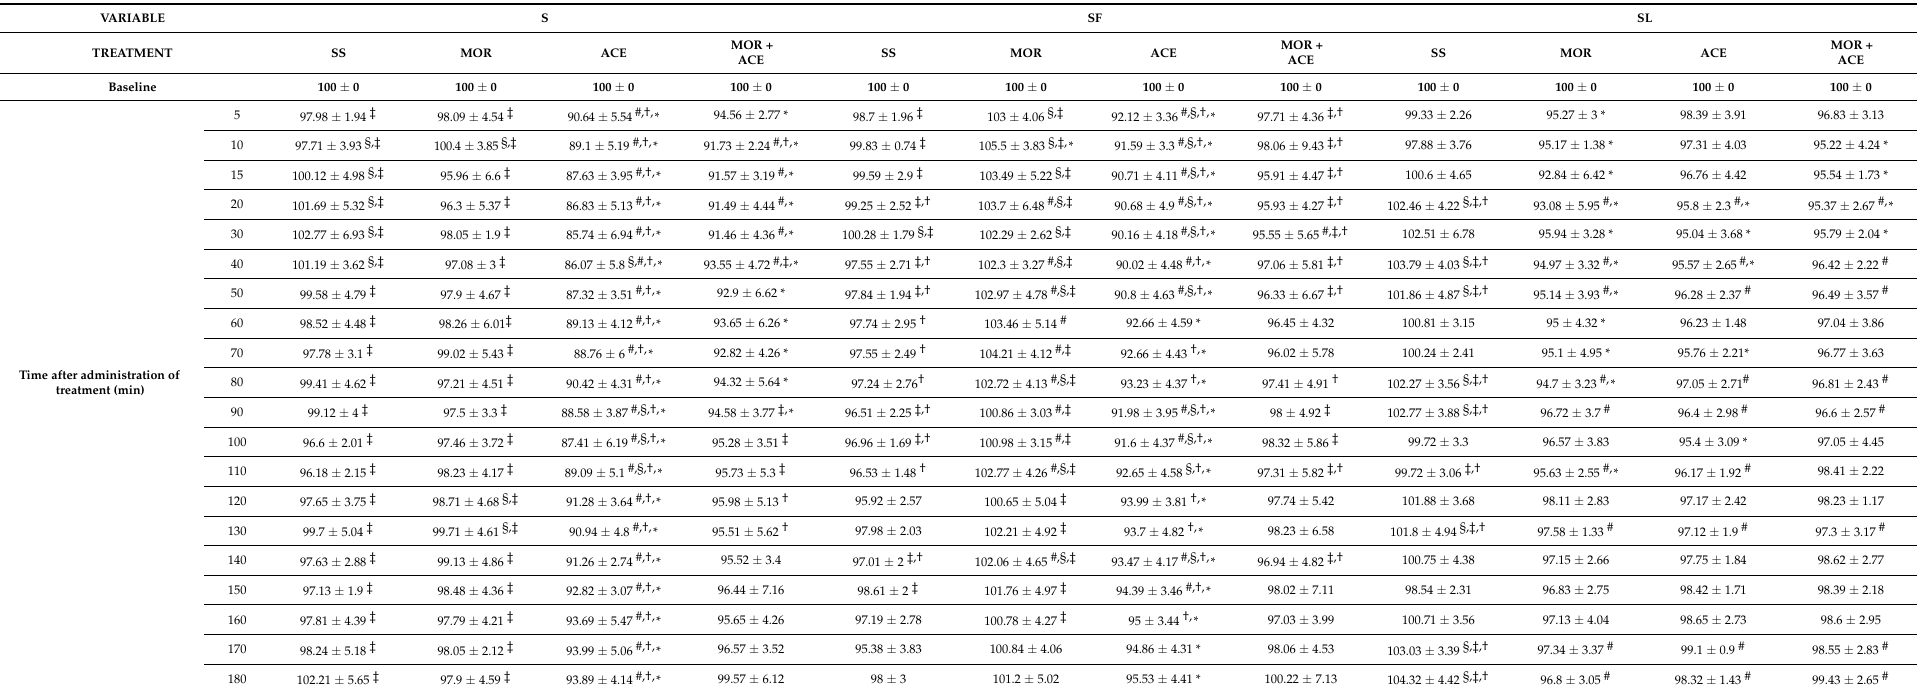
Table 1. Values at walk of stride kinematic variables at − 10, 5, 10, 15, 20, and then every 10 min (total period of 3 h) after IV injection (at 0 min) of 10 mL